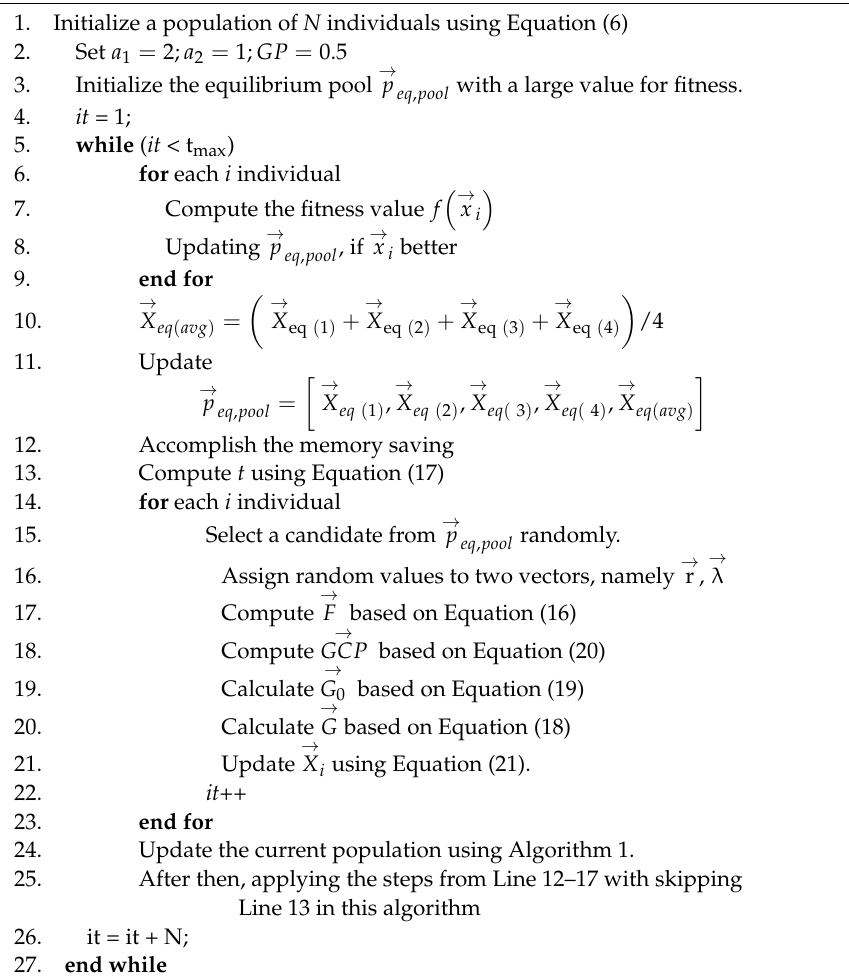
Algorithm 2 The pseudocode for the PCM integrated EO algorithm